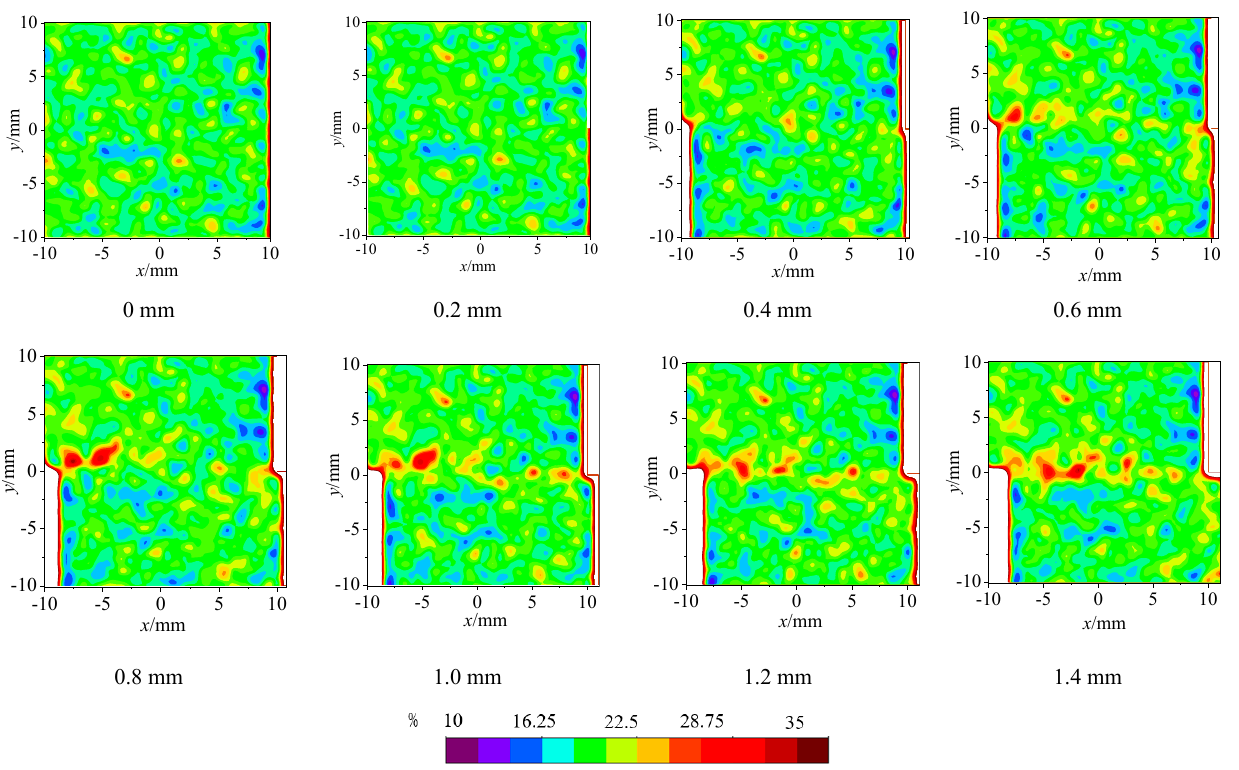
Figure 22. In the direct shear test, the porosity expansion nephogram of natural gas hydrate deposits with normal stress of 1.2 MPa and saturation of 30%.